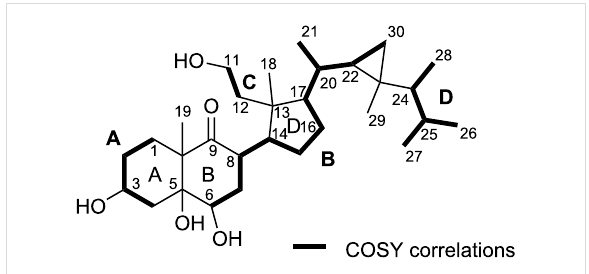
Figure 3: Significant 1 H, 1 H COSY correlations as found in compound 1 .